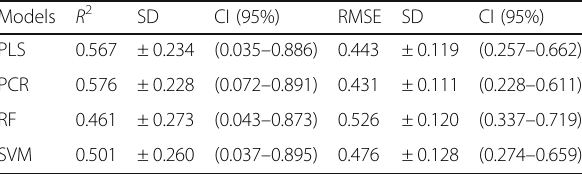
Table 6 Summary statistics of metrics RMSE and R 2 in the four models tested in the training set (50 resamples) Models R 2